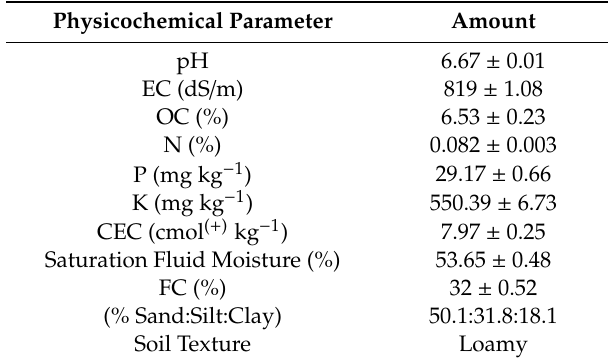
Table 3. Characteristics of rice husk biochar.